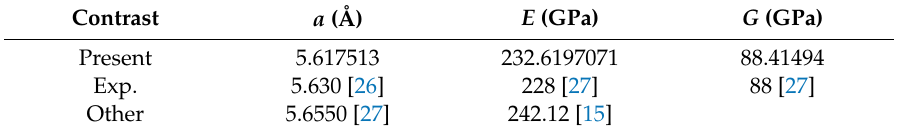
Table 1. Lattice constants a , Young’s modulus E and shear modulus B of DO3 intermetallic compound.